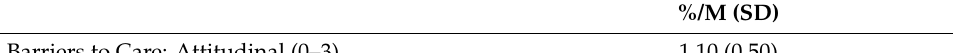
Table 2. Cont. Barriers to Care: Attitudinal (0–3) 1.10 (0.50) Barriers to Care: Instrumental (0–3) 0.62